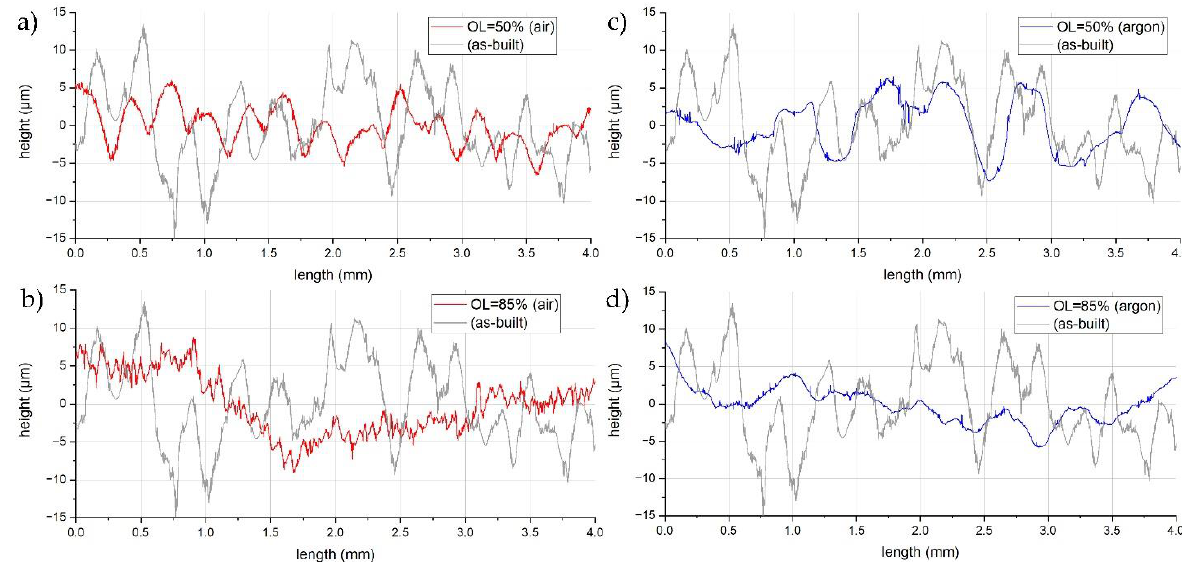
Figure 9. Single profiles perpendicular to the scanning direction, extracted from the topographies (Figure 8): ( a ) OL = 50% (air, 1.o), ( b ) OL = 85% (air, 5.o), ( c ) OL = 50% (argon, 1.a), and ( d ) OL = 85% (argon, 5.a).